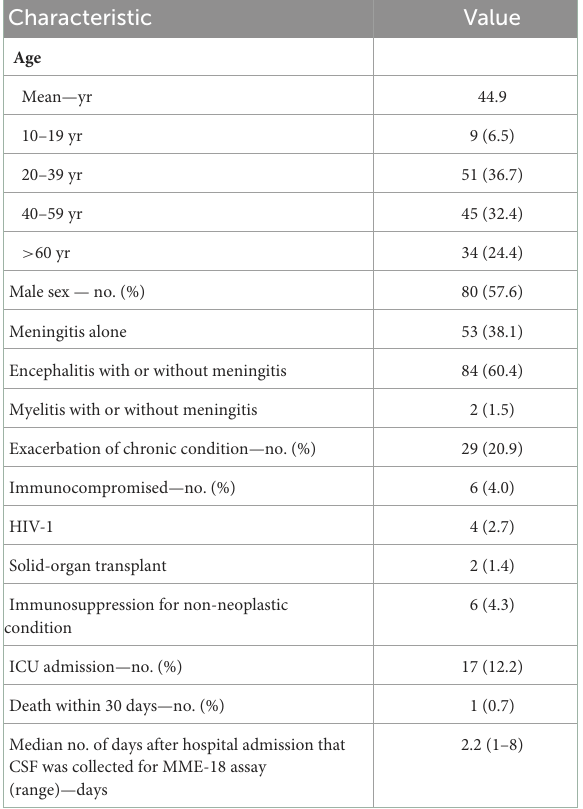
TABLE 1 Demographic and clinical characteristics of the 139